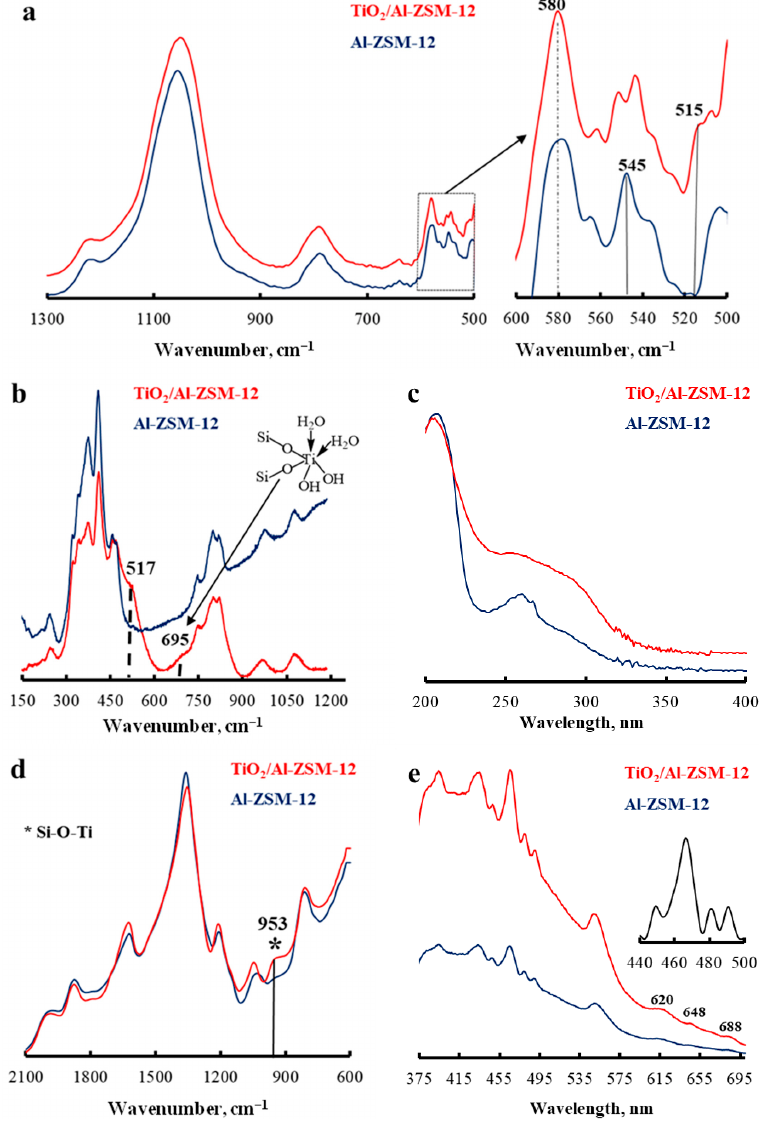
Figure 4. ( a ) IR-, ( b ) Raman-, ( c ) DRS UV–Vis-, ( d ) DRIFTS-, ( e ) PL-spectra (insert is lamp emission spectrum) of synthesized zeolites. The presence of tetrahedral titanium in the TiO 2 /Al-ZSM-12 sample, which forms Si– O–Ti bonds, is confirmed by bands with maxima at 517 cm − 1 (Raman, Figure 4b) [42,43] and 953 cm − 1 (DRIFTS, Figure 4d) [44,45]. The Raman spectrum of the TiO 2 /Al-ZSM-12 zeolite also contains a band with the maximum at 695 cm − 1 , which is responsible for the